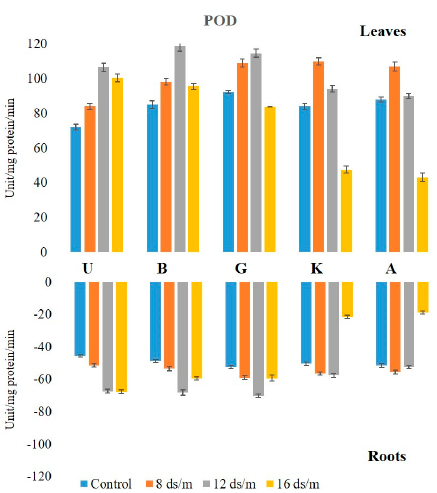
Figure 4. Effect of NaCl-mediated stress at 100 days of treatment on POD activity in leaves and roots of pistachio.